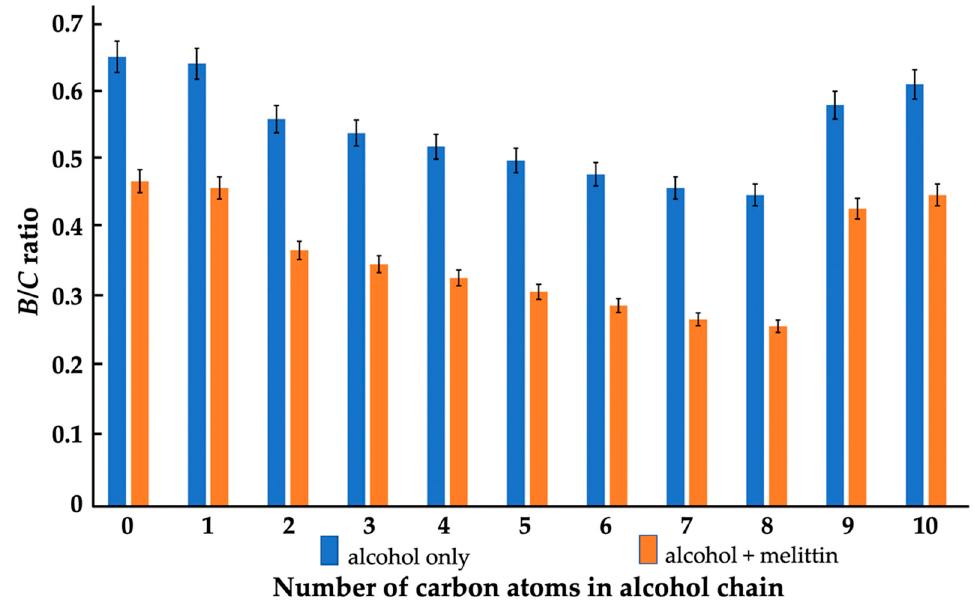
Figure 4. Effects of alcohols (5.5 × 10 − 4 M) in the absence and presence of melittin (5.5 × 10 − 5 M) on the B / C ratio of the EPR spectra of 5-DSA in oriented lipid films made of a phospholipid composition which mimics that of the IMM in eukaryotes. Concentrations of the total phospholipids and 5-DSA in the lipid films were 5.5 × 10 − 3 M and 5.5 × 10 − 5 M, respectively. Standard deviations, shown as error bars, were within 5.2% of the means.